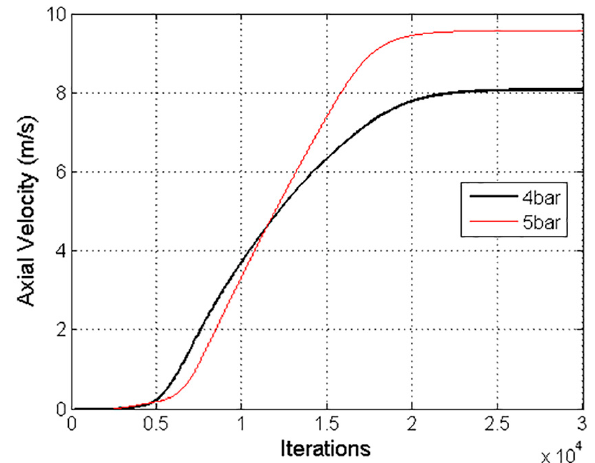
Figure 8. Axial air velocity values with pressures of 4 bar and 5 bar, considered to confirm the convergence of the numerical solution.